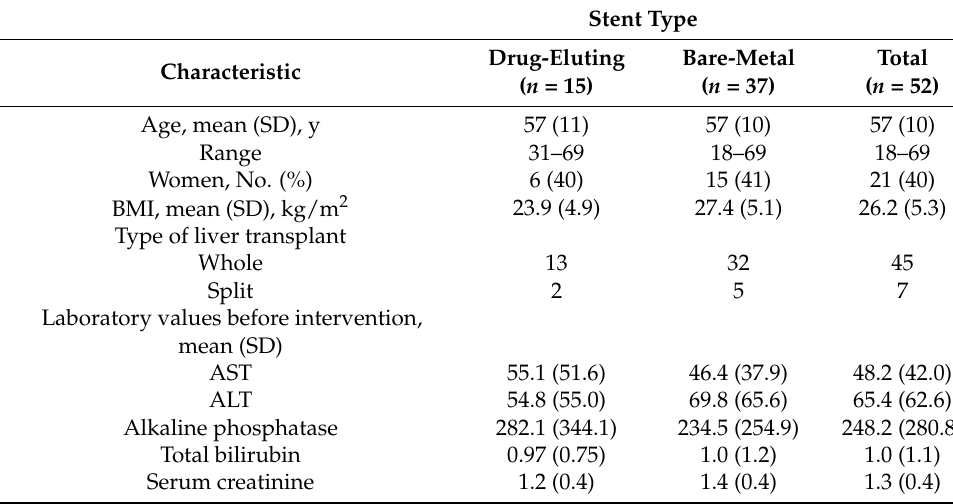
Table 1. Demographic and clinical characteristics of patients undergoing drug-eluting or bare-metal stent